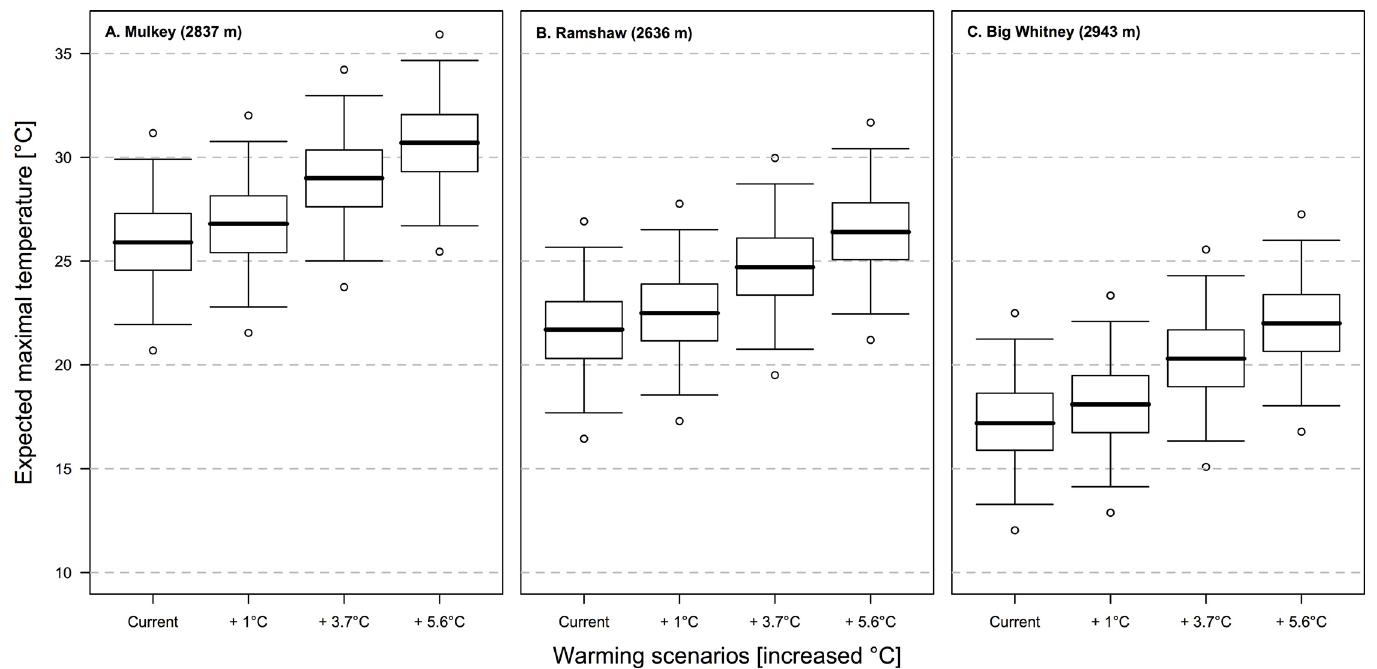
Fig 7. Temperature predictions under four climatic scenarios. The four climate warming scenarios represent: (1) the current situation, (2) a moderate increase of 1°C in air temperature, (3) a more realistic scenario of 3.7°C increase in air temperature, and (4) the worst-case scenario for the U.S.A., with a 5.6°C increase in air temperature. The boxplots represents, for each meadow and each scenario, the expected maximal temperature (DmaxT) (black line), the 50% prediction interval, i.e., the maximal temperatures expected every other year (box), the 95% prediction interval, i.e., the maximal temperatures (DmaxT) expected every twenty years (upper whiskers), and the 99% prediction interval, i.e., the maximal temperatures (DmaxT) expected every one hundred years (upper circle).